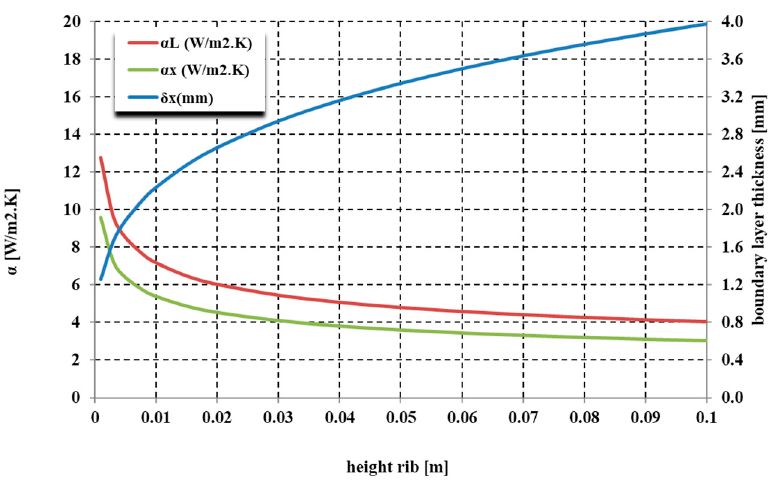
Figure 10. Dependence of boundary layer thickness and the average heat transfer coefficient on the rib height. (wall temperature t w = 18 °C)